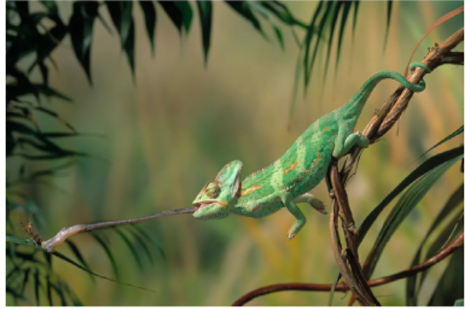
Figure 6. Hunting behavior of